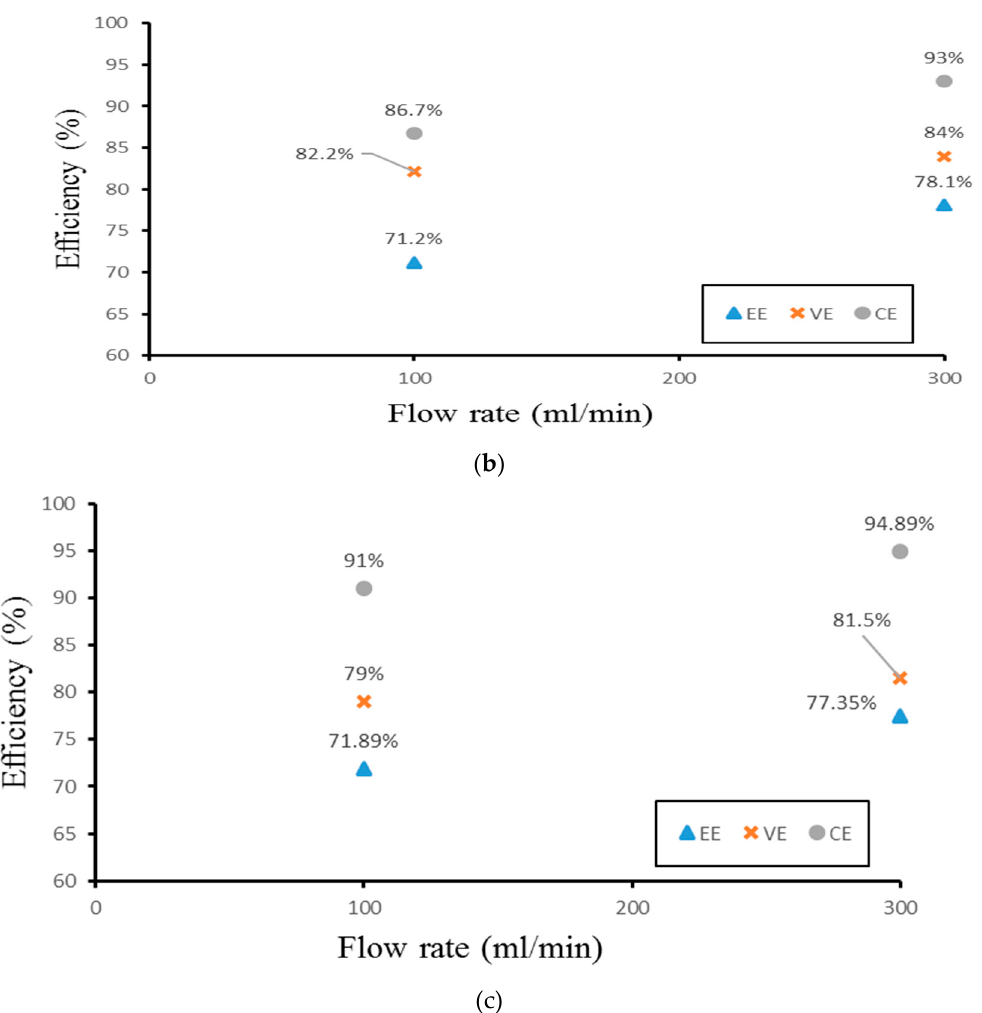
Figure 15. Efficiencies between flow rate of Case 4 at ( a ) 40 mA/cm 2 , ( b ) 60 mA/cm 2 , and ( c ) 70 mA/cm 2 from experiment.